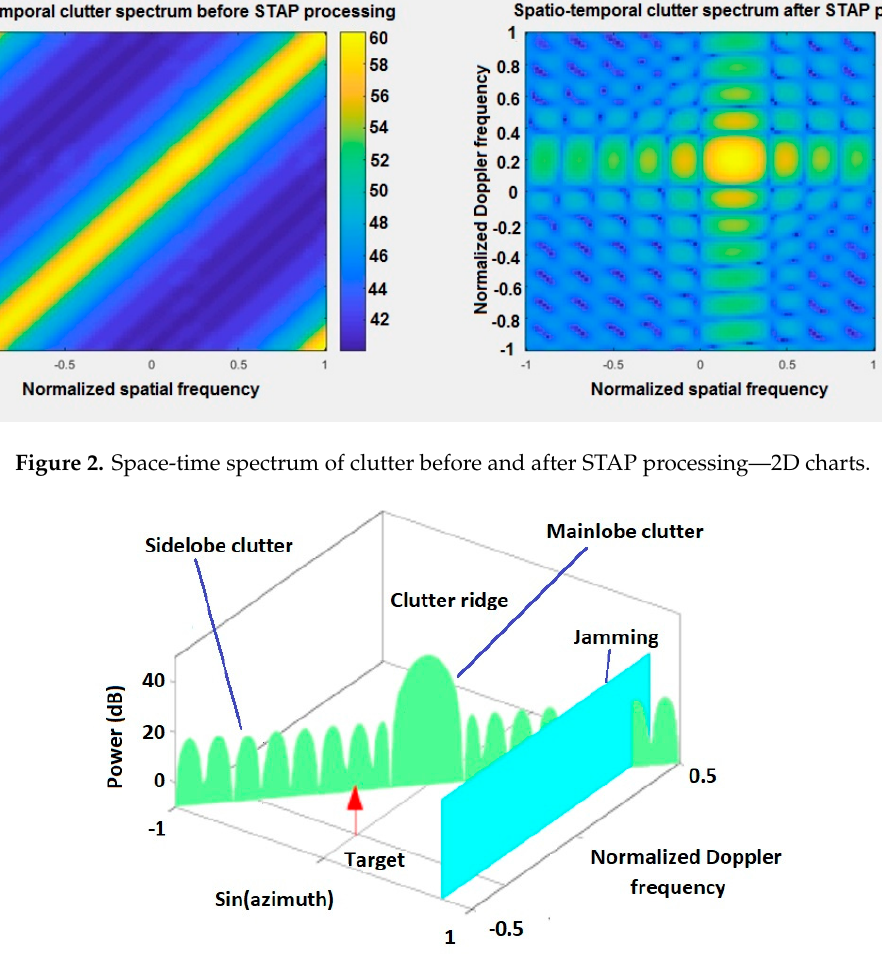
Figure 3. Clutter ridge in angular-Doppler plane.